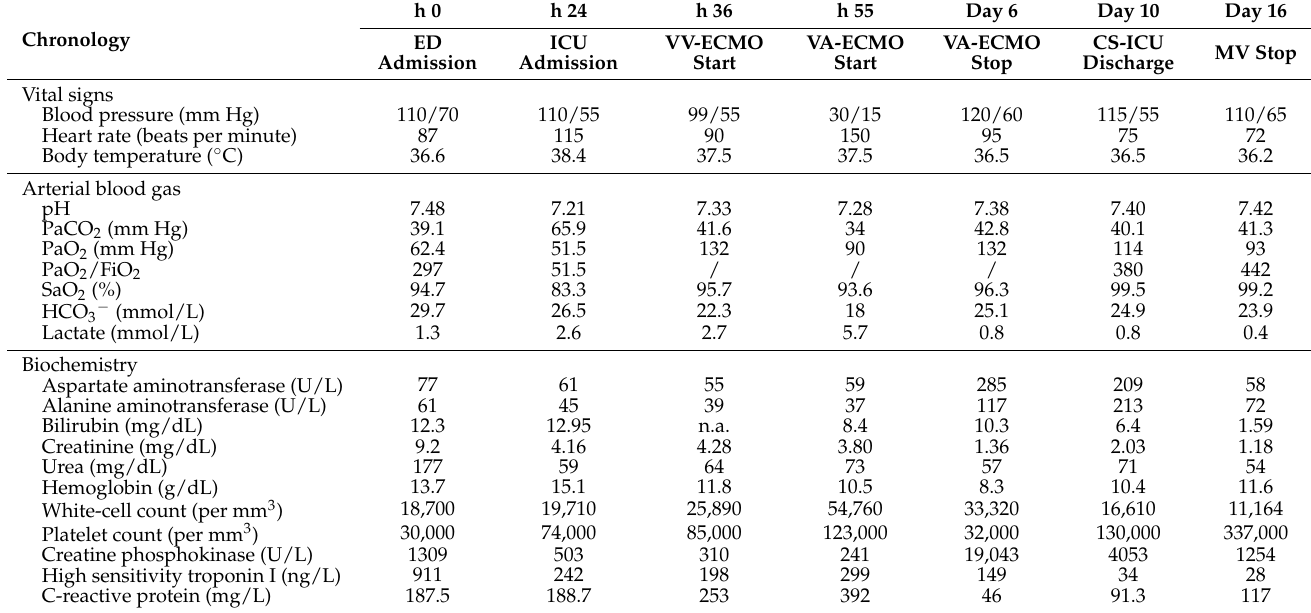
Table 1. Evolution of patient’s clinical parameters during the hospital